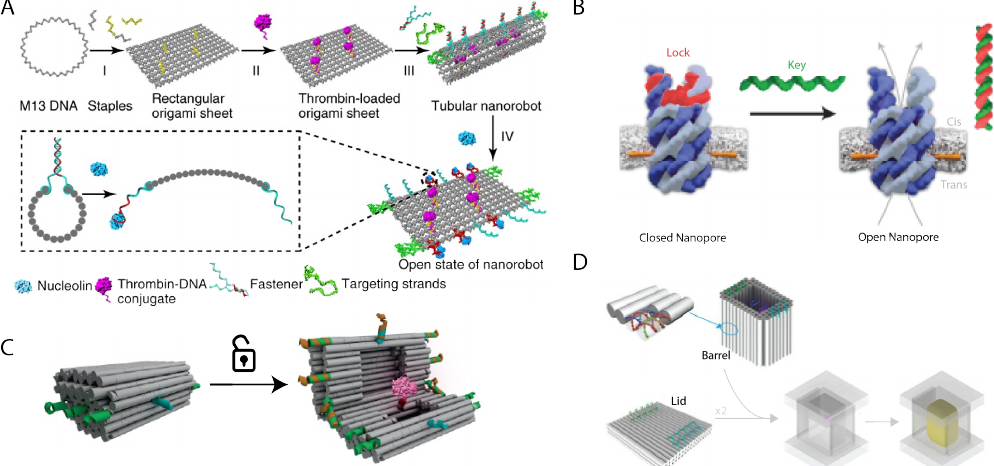
Figure 6. Applications of encapsulating DNA nanostructures. ( A ) A DNA nanorobot that selectively delivers thrombin to a tumor site to induce thrombosis of the tumor to destroy it (reprinted with permission from Springer Nature [97]); ( B ) A DNA nanopore with a locking mechanism that can restrict a flow of molecules through the channel (reprinted with permission from American Chemical Society [98]); ( C ) A DNA origami nanovault functions as a nanoreactor by capturing a single enzyme within its cavity and controlling its reactions via a latch mechanism (reprinted with permission from Springer Nature [99]); ( D ) A DNA origami mold that is used for nanocasting of gold nanoparticles (reprinted with permission from AAAS